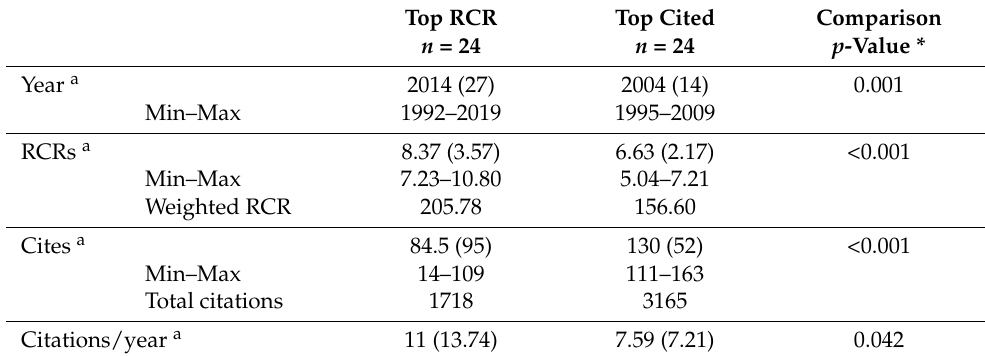
Table 6. Comparison of characteristics of root canal disinfection articles with the highest RCRs and top ‐ cited. The 24 articles not common to both lists 1990–2019.